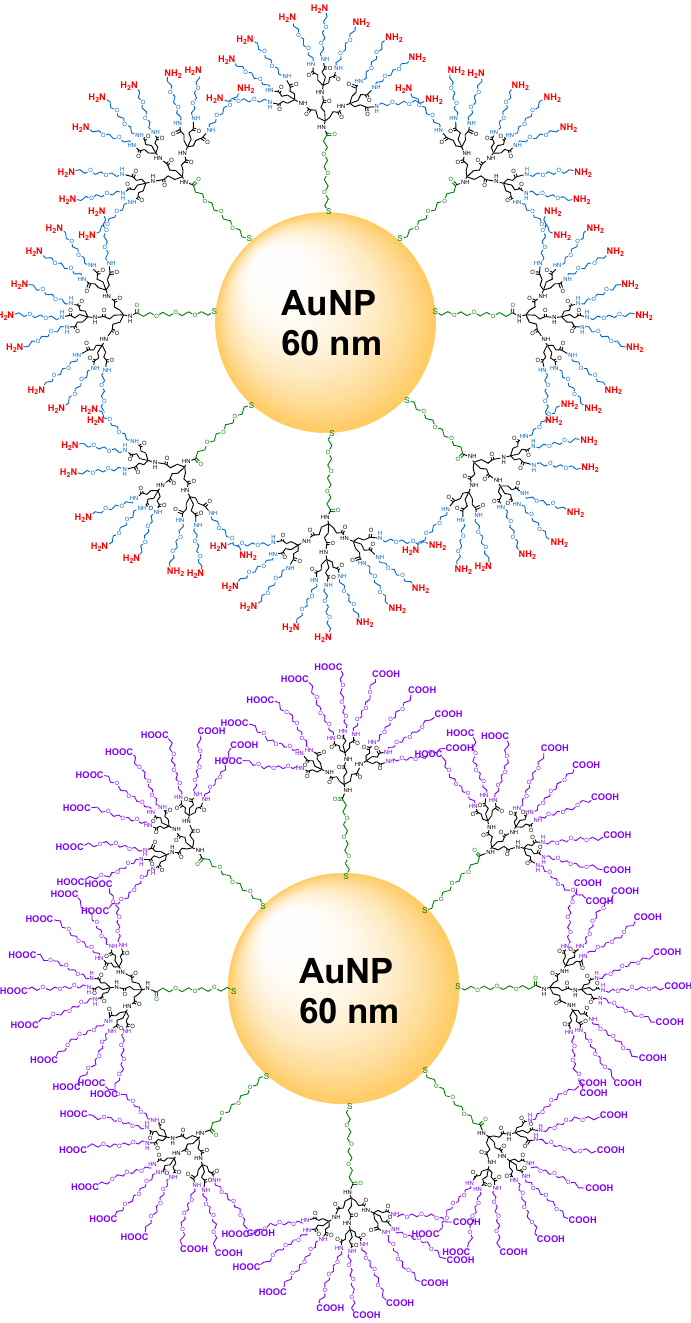
Figure 1. Dendronized gold nanoparticles with amine or carboxylic acid termini synthesized in this work.